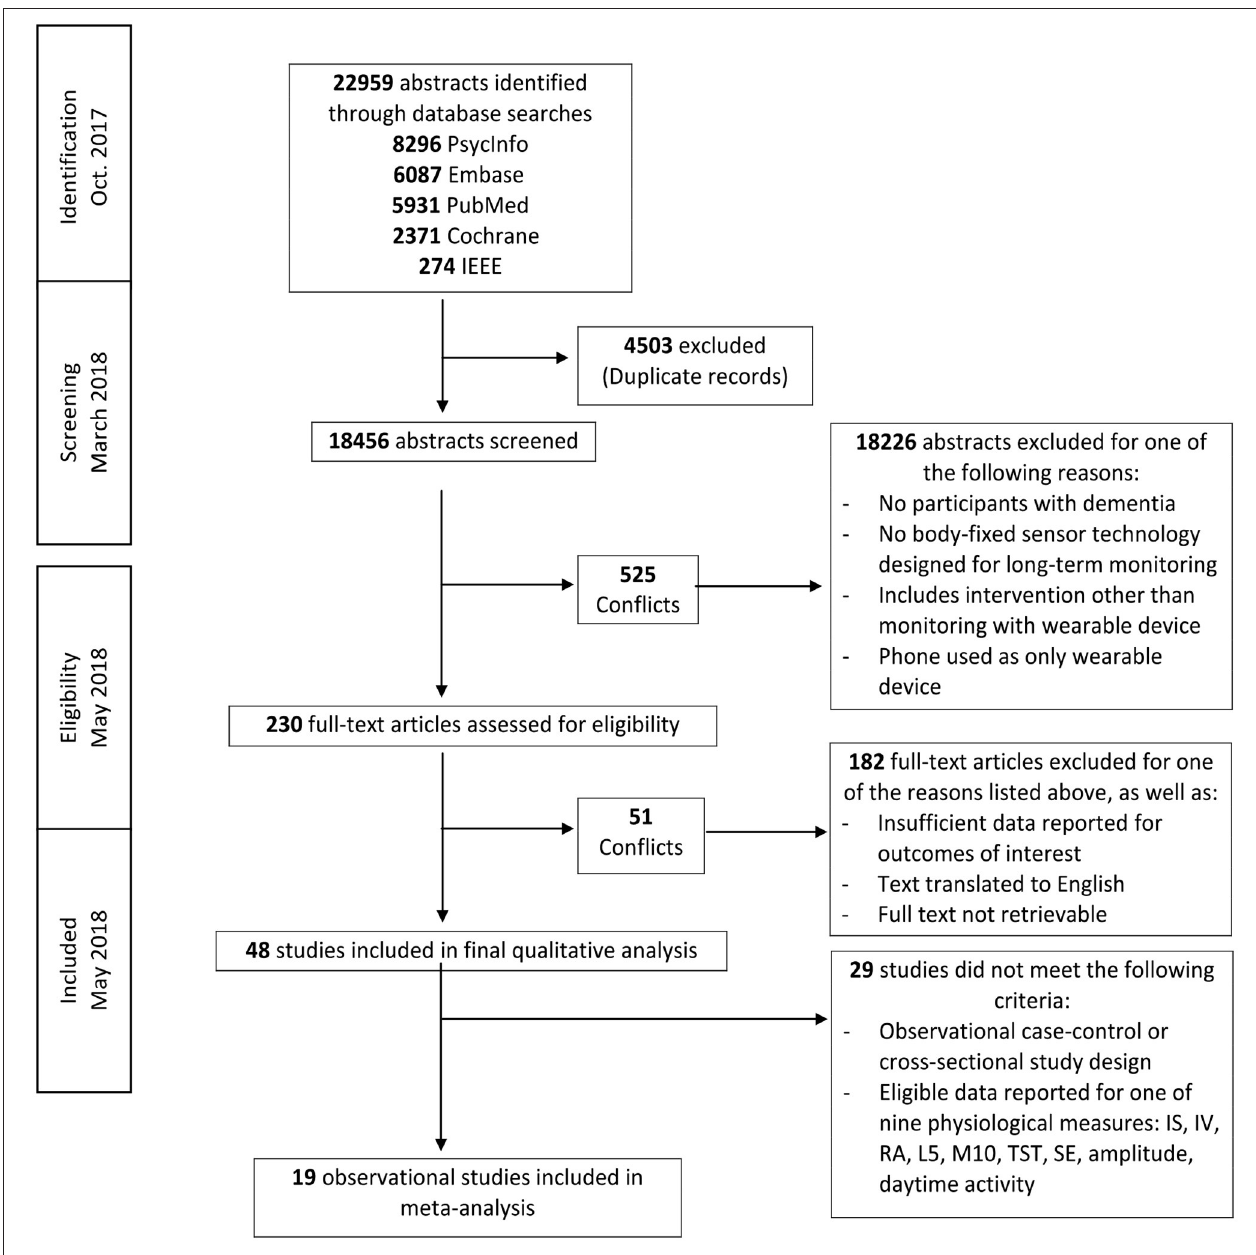
FIGURE 1 | Literature search flow